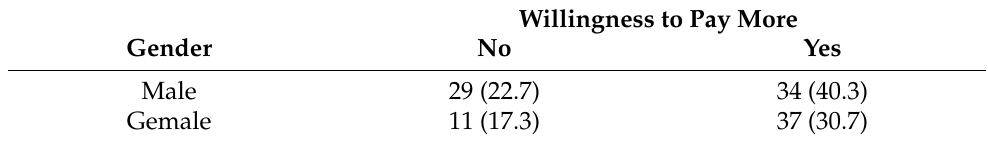
Table 4. Observed and expected frequencies.